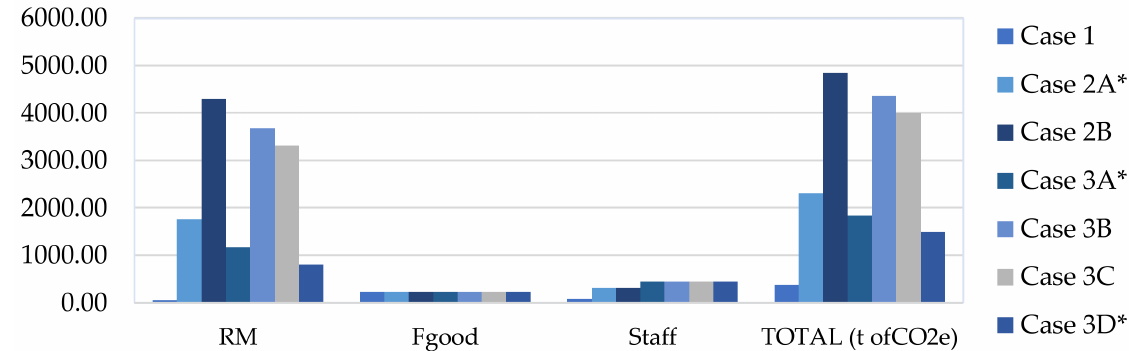
Figure 8. Total CO 2e generated due to the product logistics system, split into the different sorts of goods shipped and the staff commuting.